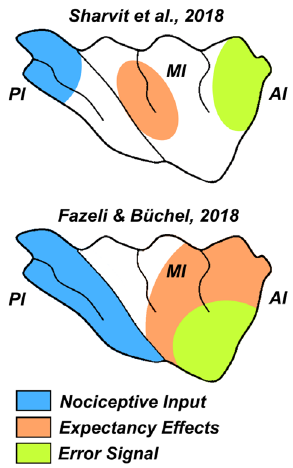
Figure 1. Schematic representation of sensory-specific expectancy processing in the insular cortex from the studies of Sharvit and others 23 and Fazeli and Büchel 24 . Blue shades over the Posterior Insula (PI) refer to processing of pain based solely on nociceptive inputs. Orange shades over the Middle (MI) and Anterior Insula (AI), refer to processing of pain (and disgust 23 ) based also on prior expectations. Green shades in AI refer to regions coding prediction errors 24 , and suppressing the effect of previous expectations 23